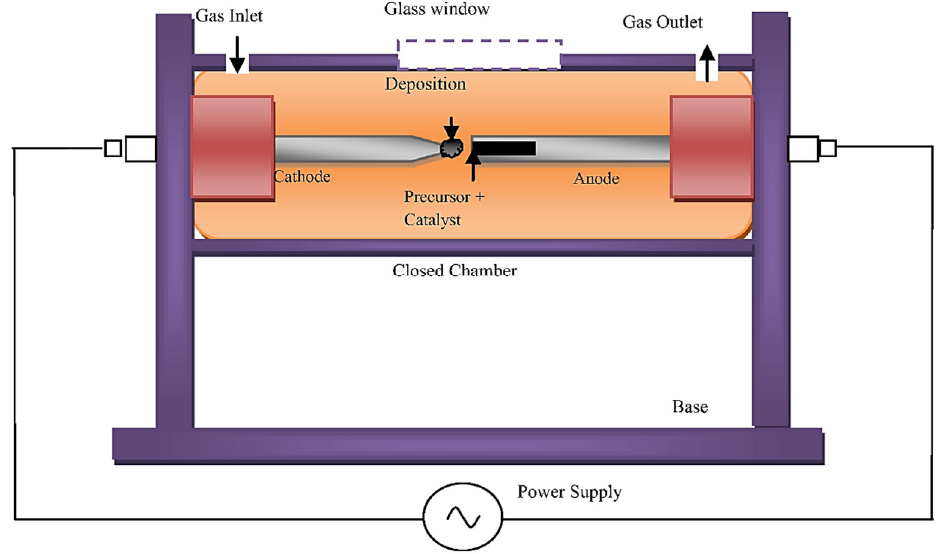
Figure 14. A araphical presentation of the arc discharge method “Reproduced with permission from [113], Elsevier, 2014”.